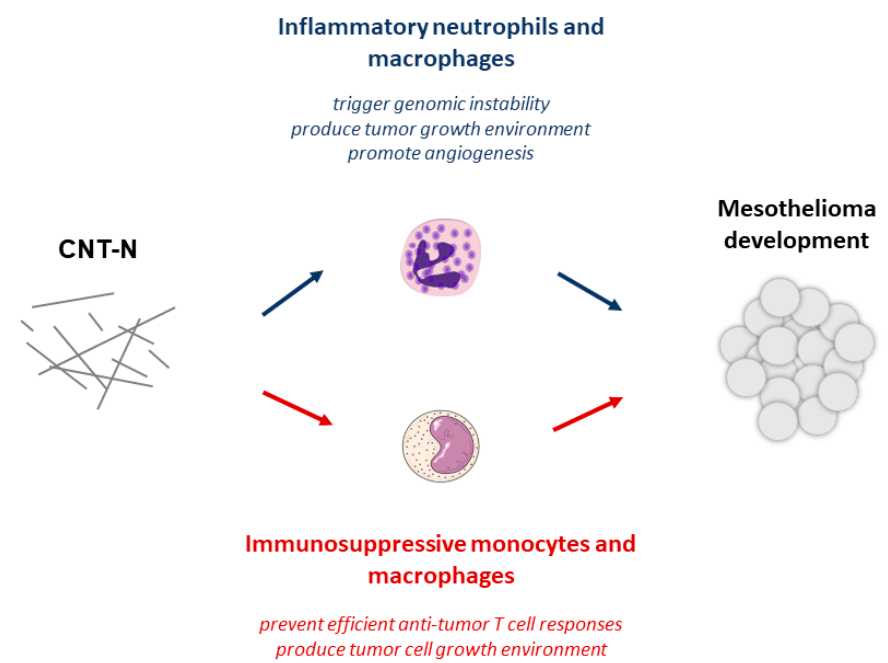
Figure 2. A new pathological pathway governs carcinogenesis induced by mesotheliomagenic needled Figure 2. Persistent inflammation and immunosuppression conjointly orchestrate carcinogenesis and CNT-N. Persistent inflammation and immunosuppression orchestrate carcinogenesis and mesothelioma. Toxic CNT-N induce an inflammatory cascade (in blue) resulting in the influx of inflammatory macrophages and neutrophils. Sustained production of free radicals by these activated immune cells induces irreversible DNA damage. Pro-inflammatory cytokines are also considered as potent polypeptide growth factors for transformed mesothelial cells and angiogenesis. An unexpected conjoint immunosuppression (in red) is induced by mesotheliomagenic CNT. These early responses to CNT-N are characterized by persistent accumulation of immunosuppressive macrophages and monocytes and a sustained production of regulatory cytokines (i.e., IL-10 and TGF- β ). These immunoregulatory components are incriminated in carcinogenesis by preventing host immune responses directed against transformed cells and favoring tumor